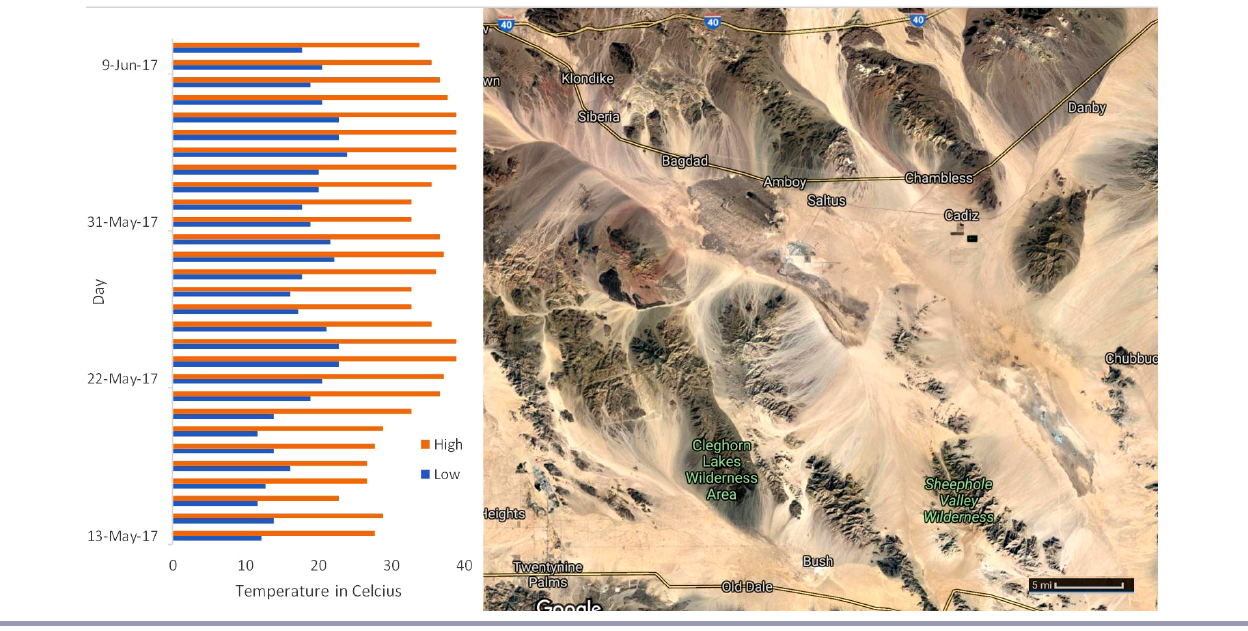
Fig. 2. Map of the area around Amboy, California, USA. The nearest town with running water and services is Twentynine Palms (bottom left of map), which is 80 km from Amboy. Left of the map is the high and low temperature profile in Twentynine Palms (which is a few degrees cooler than in Amboy) during the project.